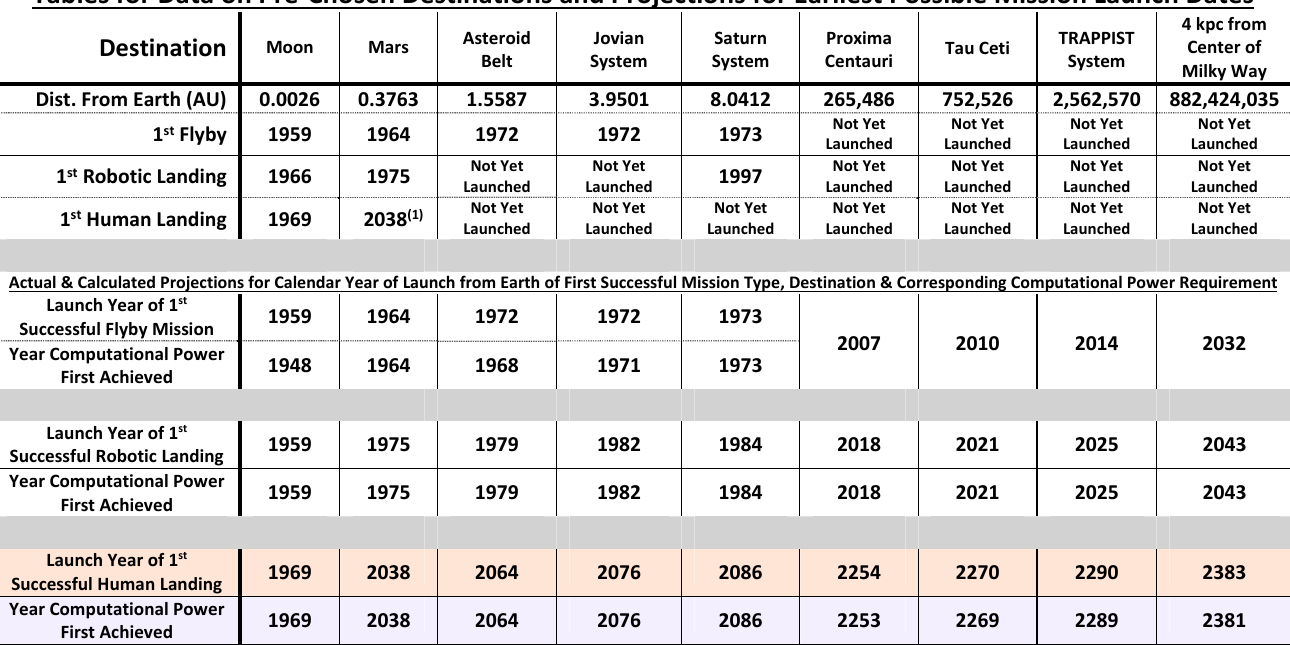
Table 1. Actual and projected timing of first successful robotic and human missions for selected destinations within the Solar System and interstellar